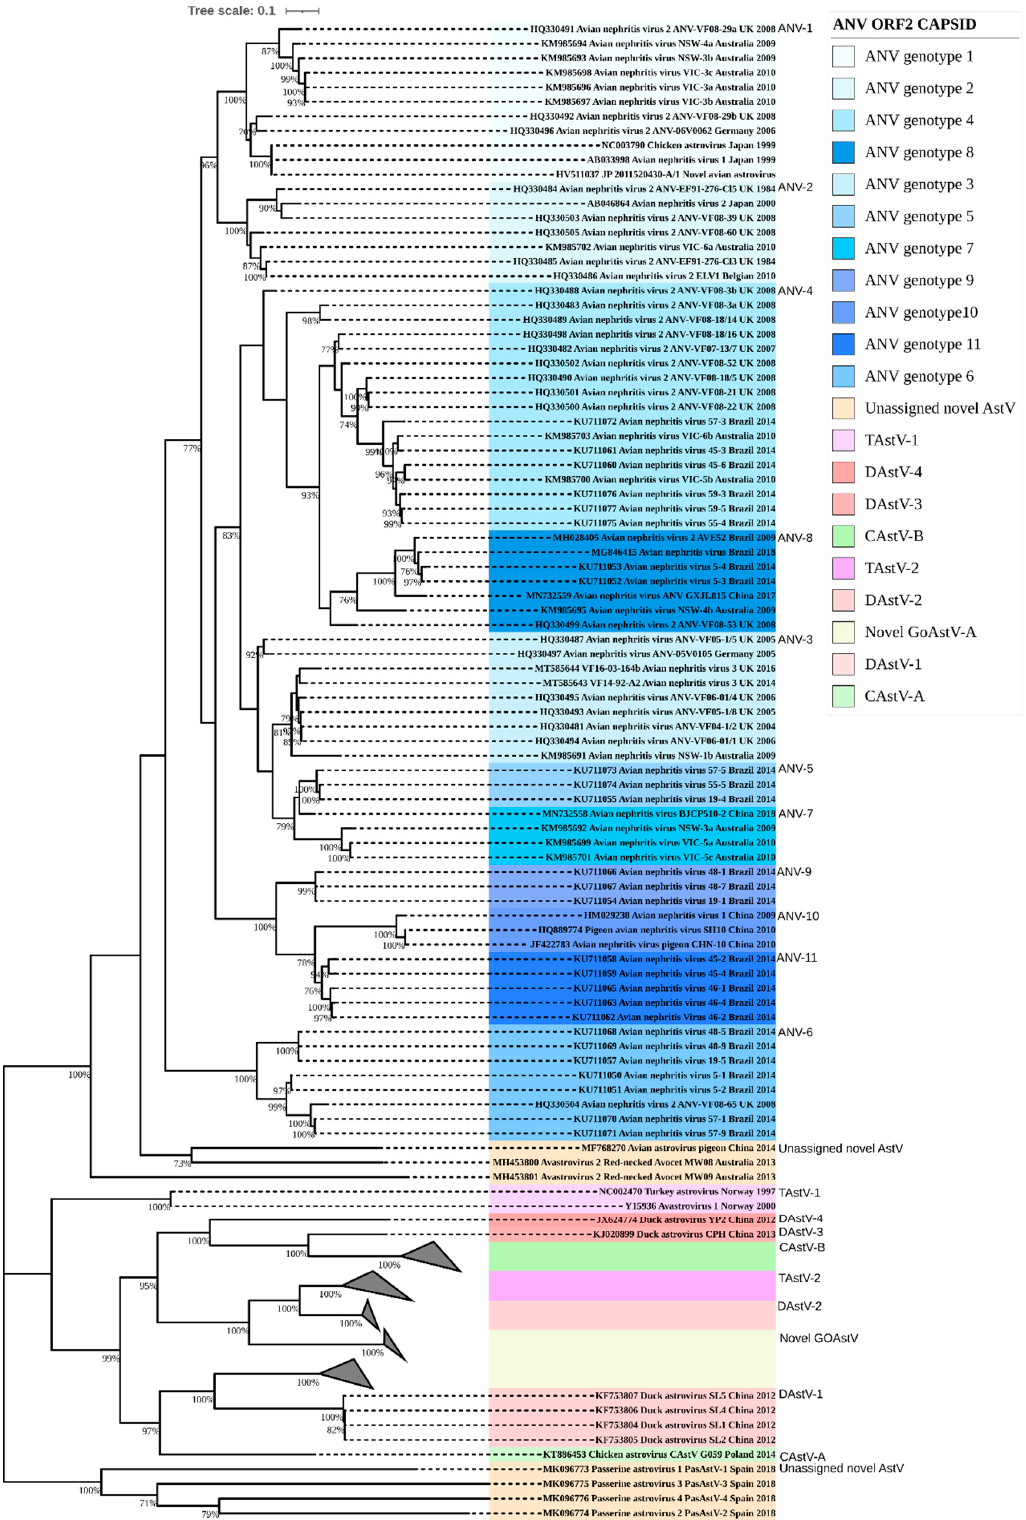
Figure 6. Astroviridae capsid ORF2 phylogeny. The Avastroviridae capsid ORF2 amino acids of 145 sequences phylogenetic analysis in MEGA X from MUSCLE-aligned sequences. Evolutionary history was inferred by maximum likelihood with bootstrapping of 1000 replicates. The tree is annotated in clades and ANV genotypes coloured blue with sequences from this study (in bold), with MT585643, VF14-92-A2, and MT585644 VF16-03-164b positioned in avian nephritis genotype 3. Clade abbreviations; CAstV = Chicken astrovirus, DAstV = Duck astrovirus, GAstV = Goose astrovirus, ANV = Avian nephritis virus, and TAstV = turkey astrovirus.